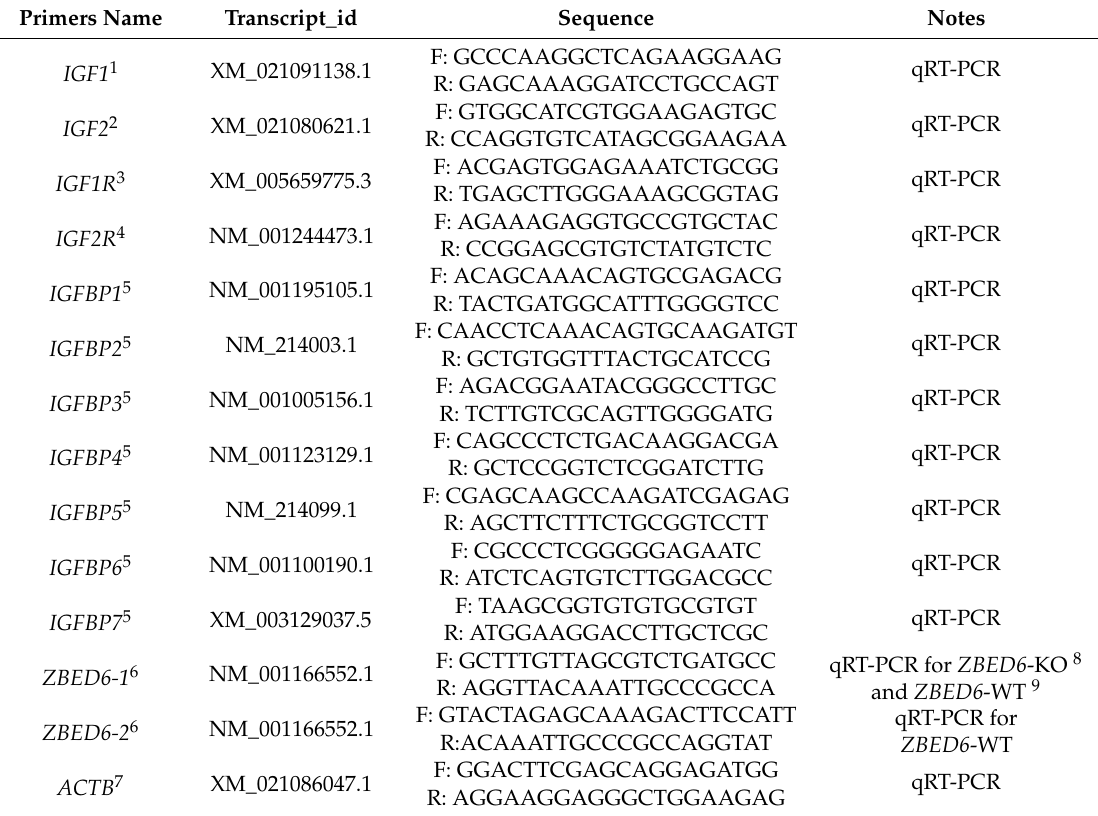
Table 1. Primers list in this